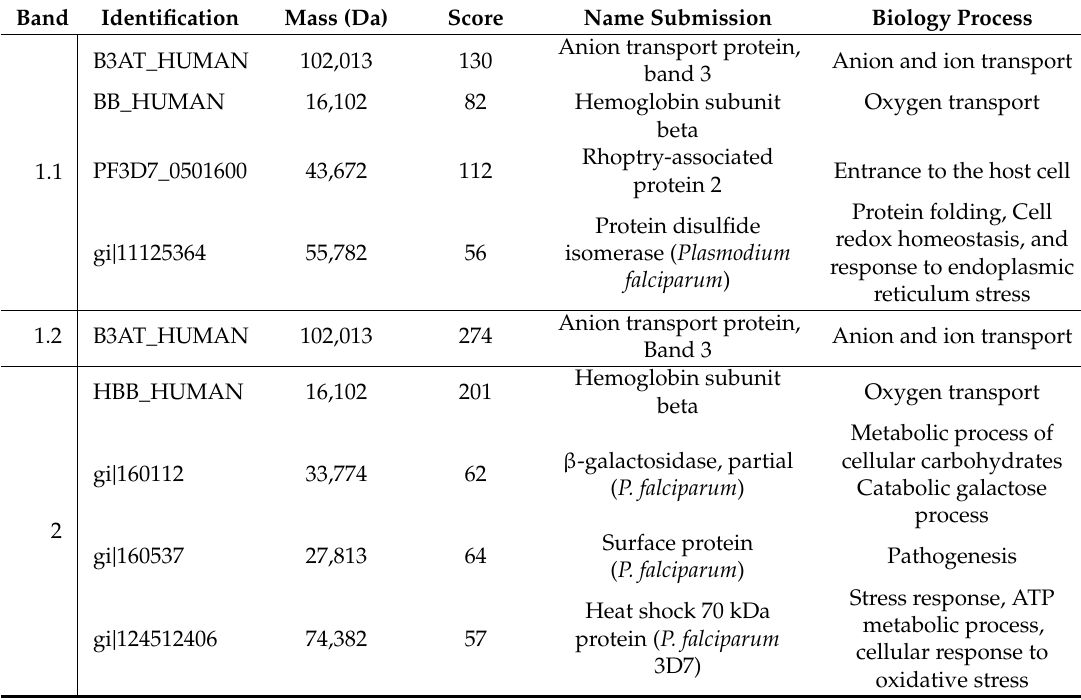
Table 3. Proteins identified in carbonylated